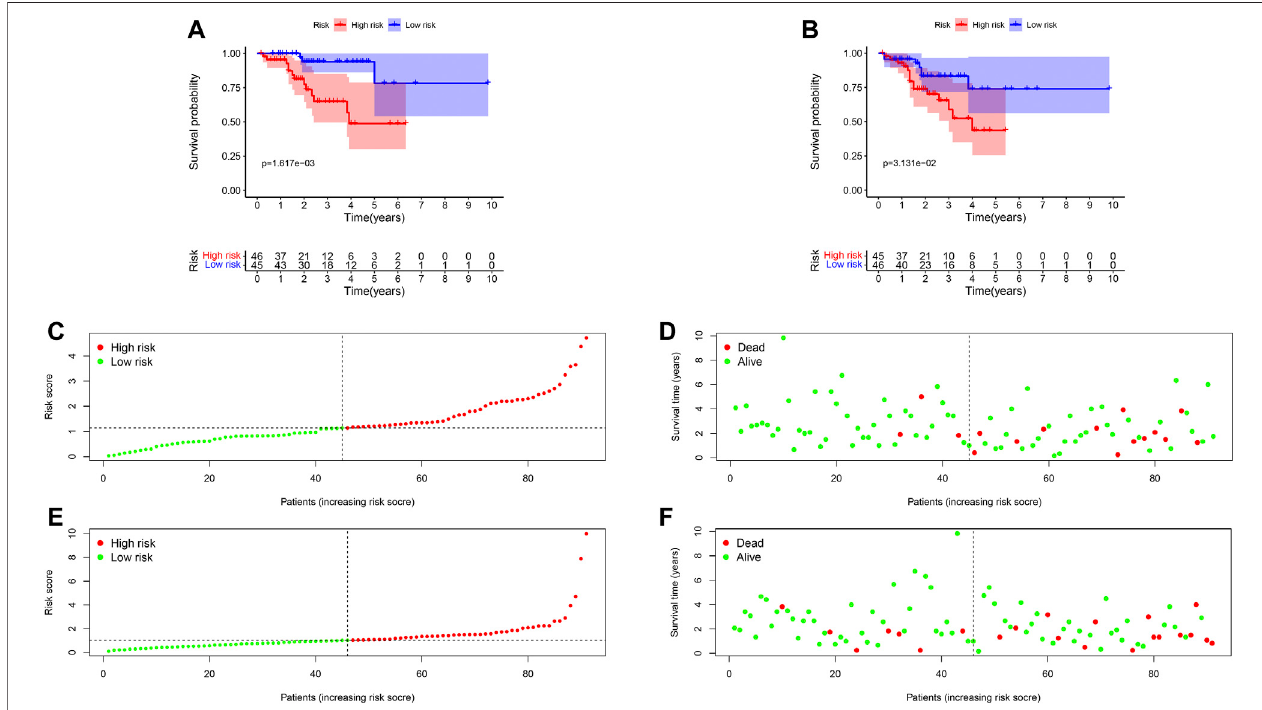
FIGURE4| Survivalcomparisonandriskscorehazardanalysesofhigh-andlow-riskgroupsinbreastcancerpatients. (A) K-McurveforOS;Theresultshowedthe survival status is signi fi cantly different between the two groups ( p (cid:1) 0.004). (B) K-M curve for RFS; High-risk groups patients had worse RFS than that in the low-risk group ( p (cid:1) 0.021). (C) Risk score hazard curve for OS. The dotted line indicated the individual in fl ection point of the risk score curve, by which the patients were categorized into low- and high-risk groups. Red represented high-risk and green represented low-risk. (D) Risk score scatters plot of OS in high and low-risk groups. Red dots represented the dead patients and green represented the alive. With the increase of risk scores, more patients died. (E) Risk score hazard curve for RFS. (F) Scatter plot of patients for RFS.